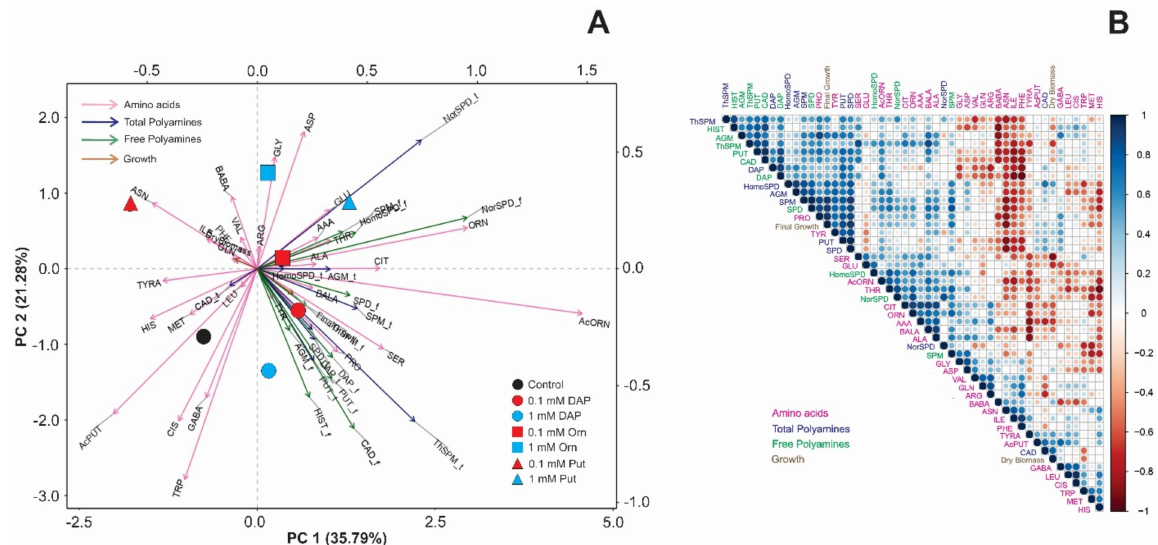
Figure 6. Principal components analysis (PCAs) ( A ) and correlation matrix ( B ) of the N-containing metabolites [free amino acids (pink arrows), total polyamines (blue arrows), free polyamines (green arrows)] and growth (dry biomass and final growth) in Arabidopsis thaliana (Col-0 ecotype) seedling from unprimed (control, black circle) or primed seeds with DAP (circles), Orn (square), or Put, (triangle) at two concentrations [0.1 mM (red symbols) or 1 mM (blue symbols)] grown under salt stress. Data were normalized using the natural logarithm. Each geometric figure (circle, square, and triangle) represents the mean values of four biological replicates ( n = 4). Blue and red colors in the correlation matrix indicate positive and negative values,